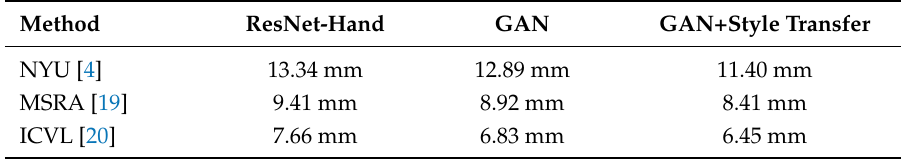
Table 4. On the NYU, MSRA, and ICVL dataset, the effects of the different parts to accuracy are compared. It proves that the entire model has better results with the average 3D joint error metric in the table